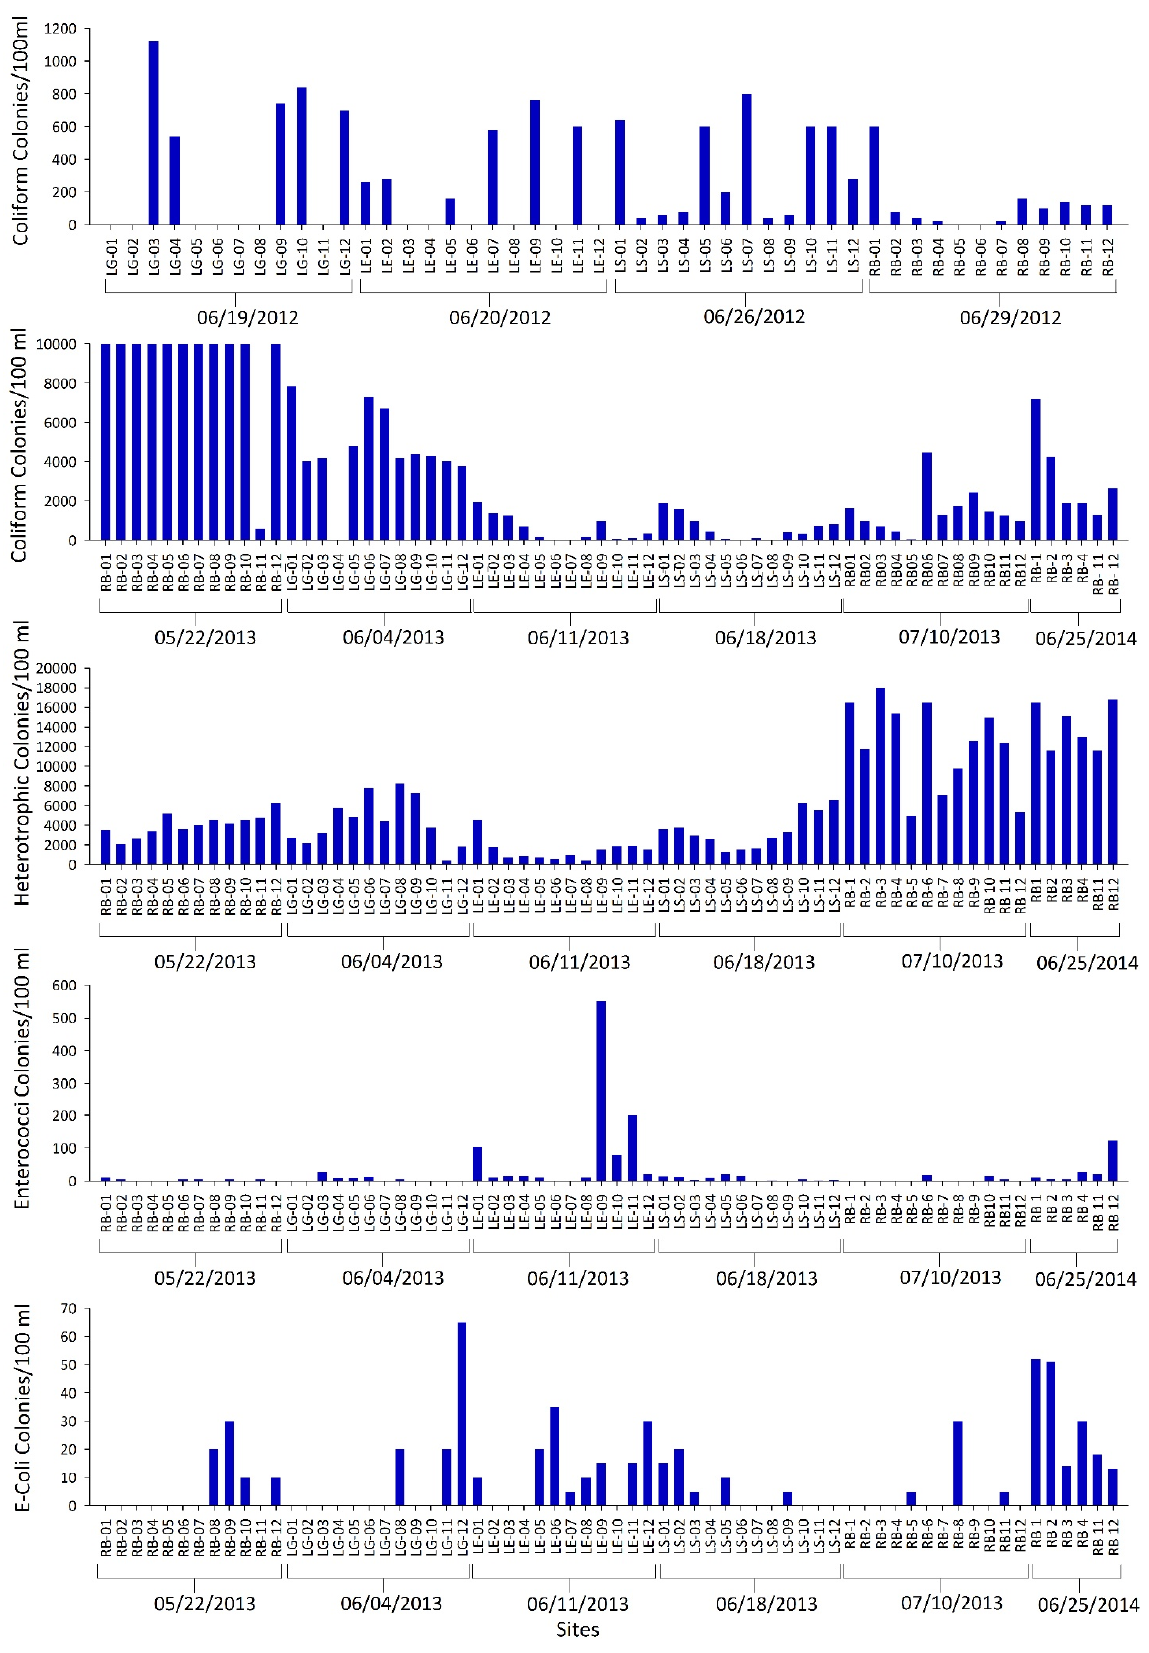
Figure 10. Bacterial colony counts at twelve sampling sites in each of the lakes (RB = Ross Barnett Reservoir, LG = Lake Grenada, LE = Lake Enid, and LS = Lake Sardis) with sampling dates